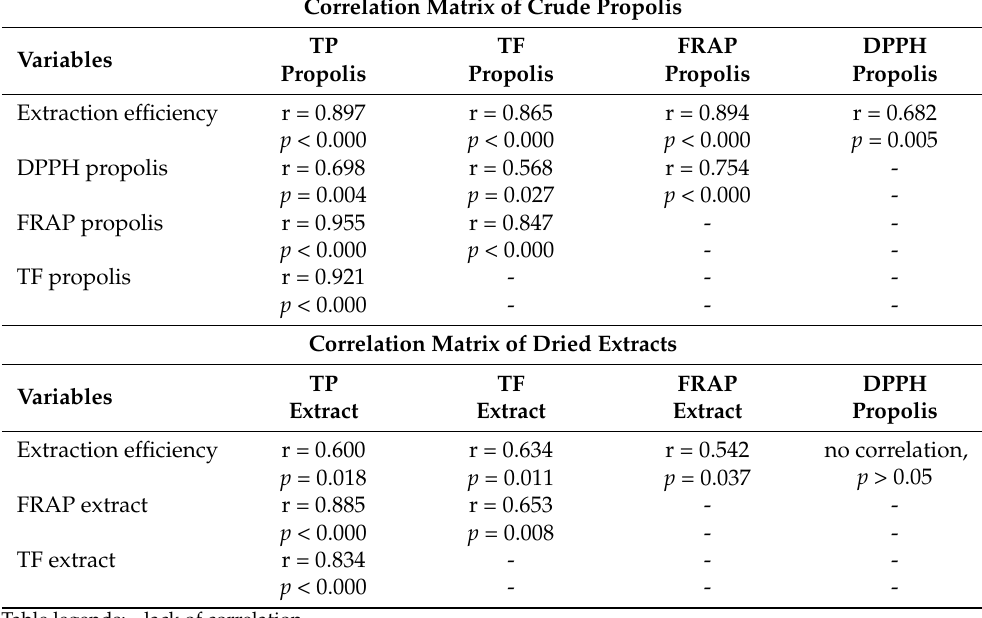
Table 4. Correlation matrices of colorimetric assays.